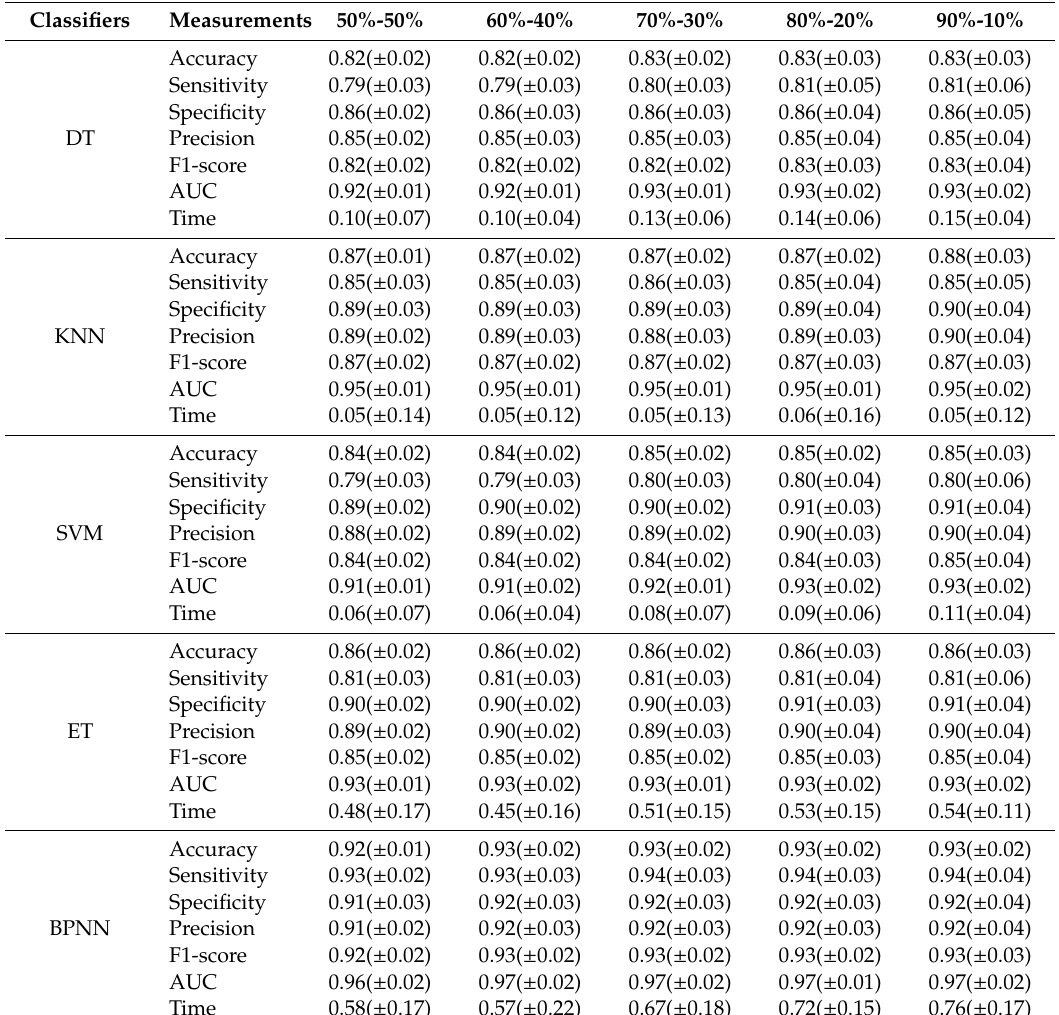
Table 5. Comparison of performance measurements generated by five di ff erent classifiers for first-stage